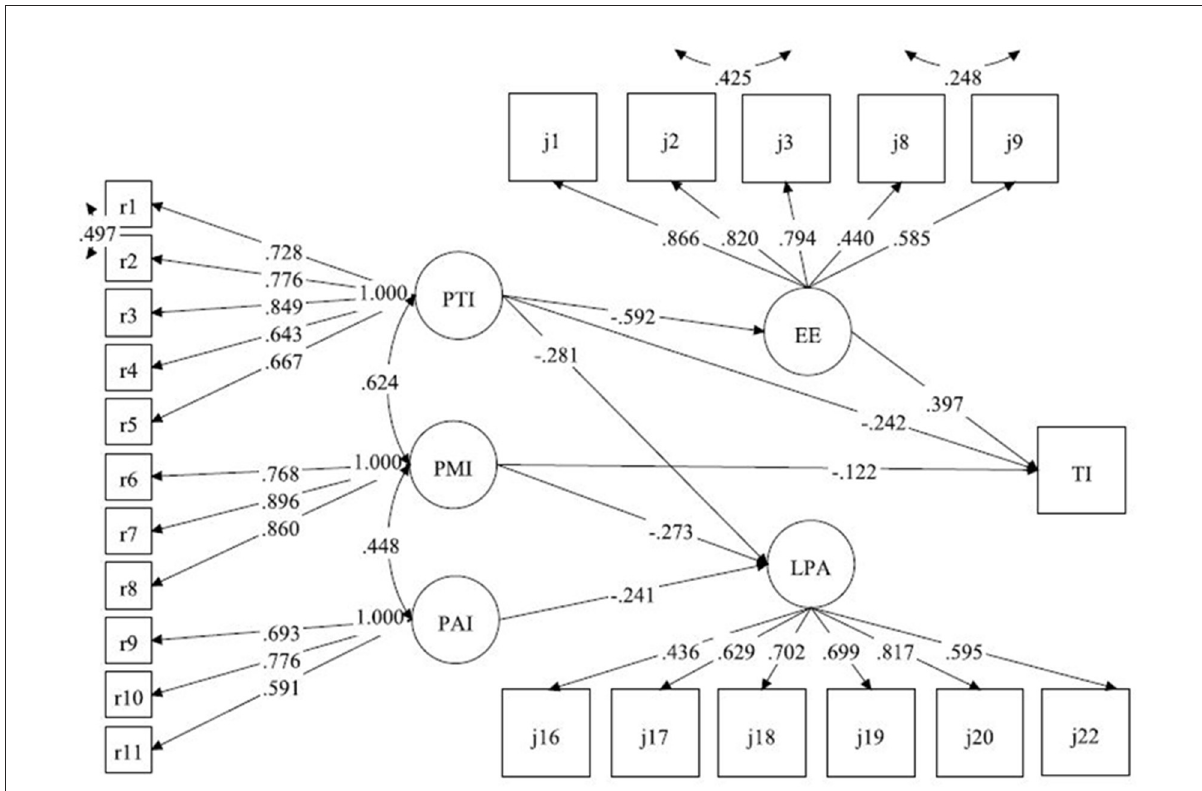
FIGURE2 Model paths and standardized coefficients pertaining to the synthesized relationships among PI, JB, and TI. PTI, professional treatment identity; PMI, professional meaning identity; PAI, professional ability identity; EE, emotional exhaustion; LPA, low personal achievement; TI, turnover